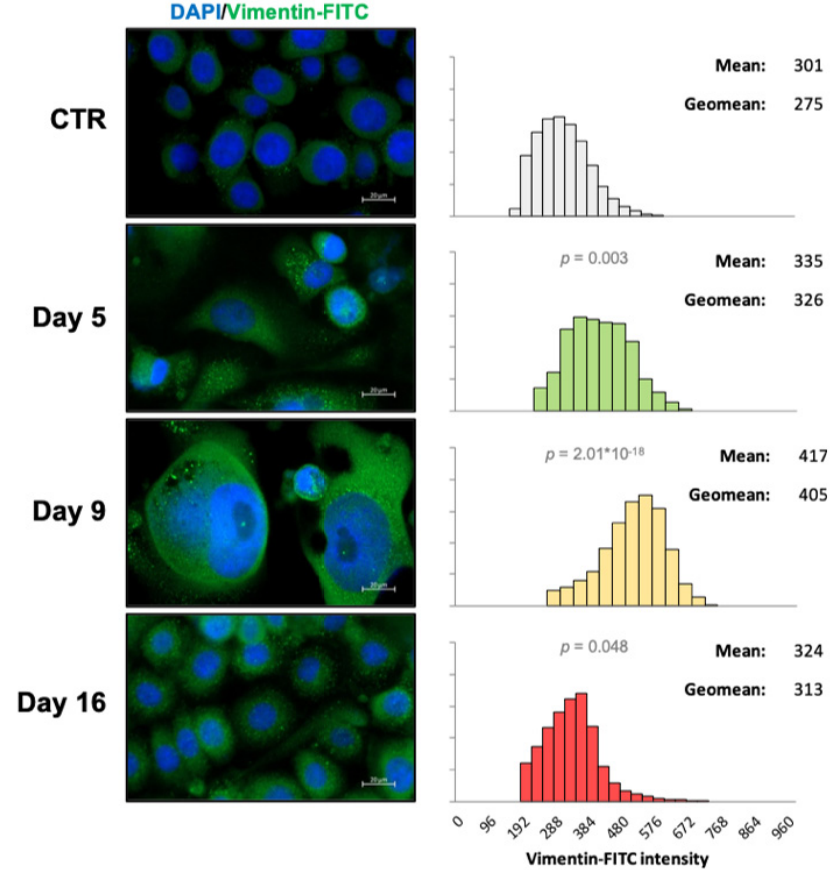
Figure 6. Dynamics of vimentin expression during the different phases of CRAC. Fluorescence microscope images and vimentin quantification (reported as the relative frequency distribution of fluorescence intensities) of PC3 cells after etoposide treatment at the indicated time points. The mean and geomean values are noted above each histogram. The images are representative of three independent experiments. Statistical significance ( p < 0.05) of each distribution with respect to control cells (CTR) was calculated via the Mann–Whitney